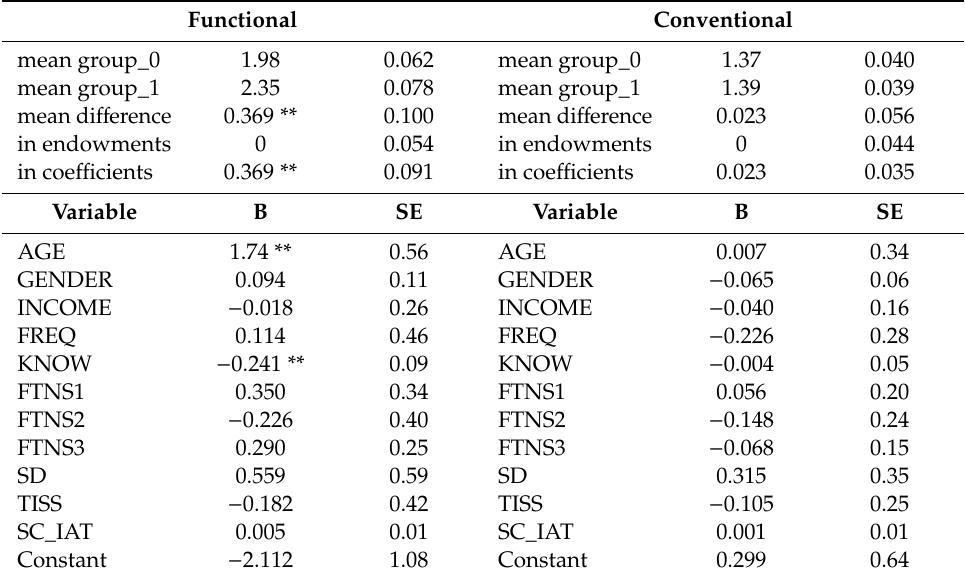
Table 7. Oaxaca-Blinder decomposition of the total di ff erence due to information ( n = 1000).